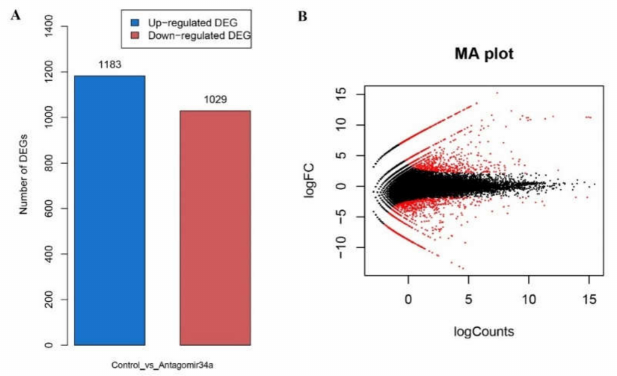
Figure 4. Differentially expressed genes in M. amblycephala in response to miR-34a inhibitor treatment. ( A ) Blue represents upregulated genes and red represents the downregulated genes in antagomiR34a-12h group vs. control group. |log2FC(Fold change)| ≥ 1 and p -value ≤ 0.05; ( B ) MA plot of all DEGs, the y -axis represents the logarithm of fold change and the x -axis represents the logarithm of read counts. Red color represents DEGs and black color represents